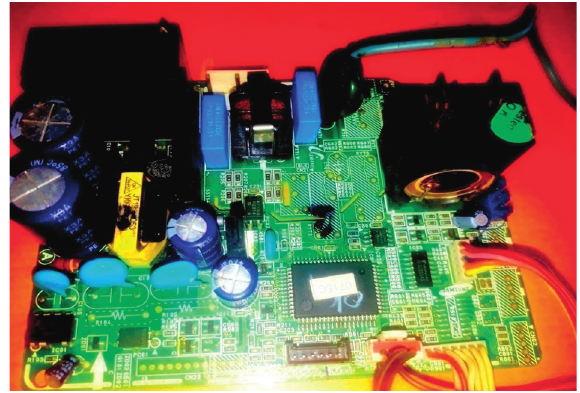
Figure 1: Schematic diagram of sample PCB. Table 1: Metal composition present in printed circuit boards reported in previous literature.